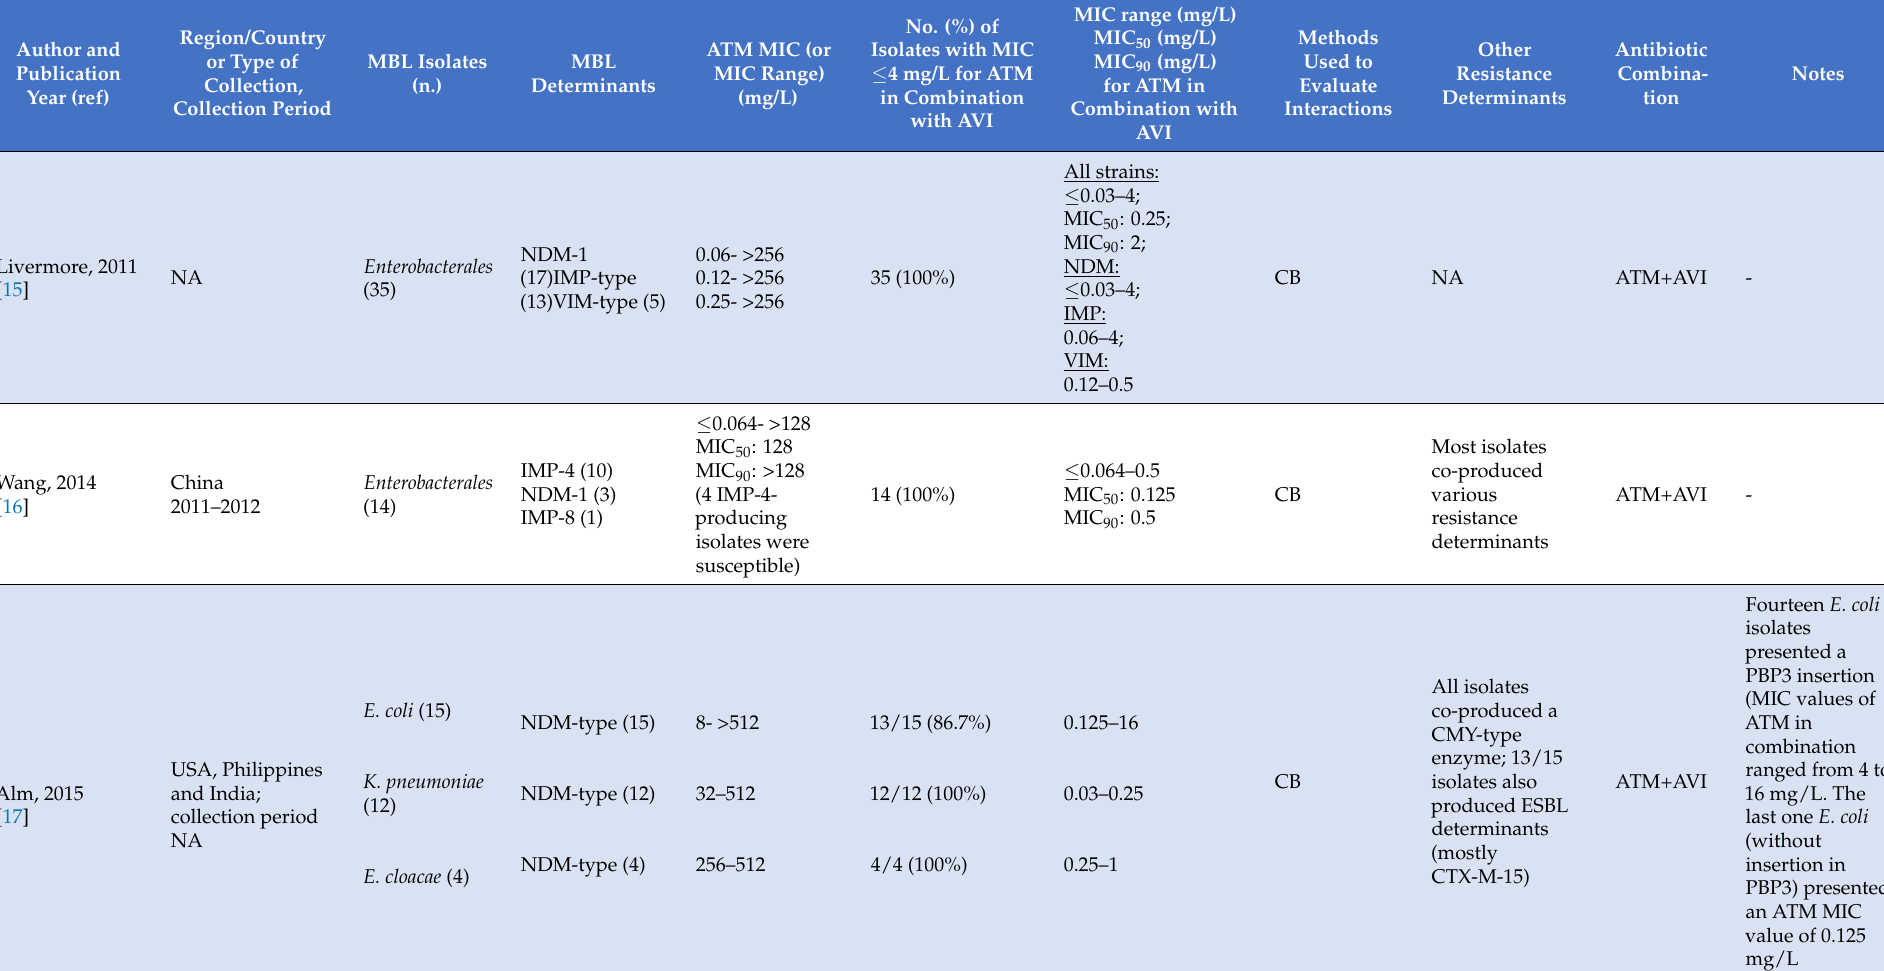
Table 1. In vitro studies on antimicrobial activity of ATM in combination with AVI or CZA against MBL-producing